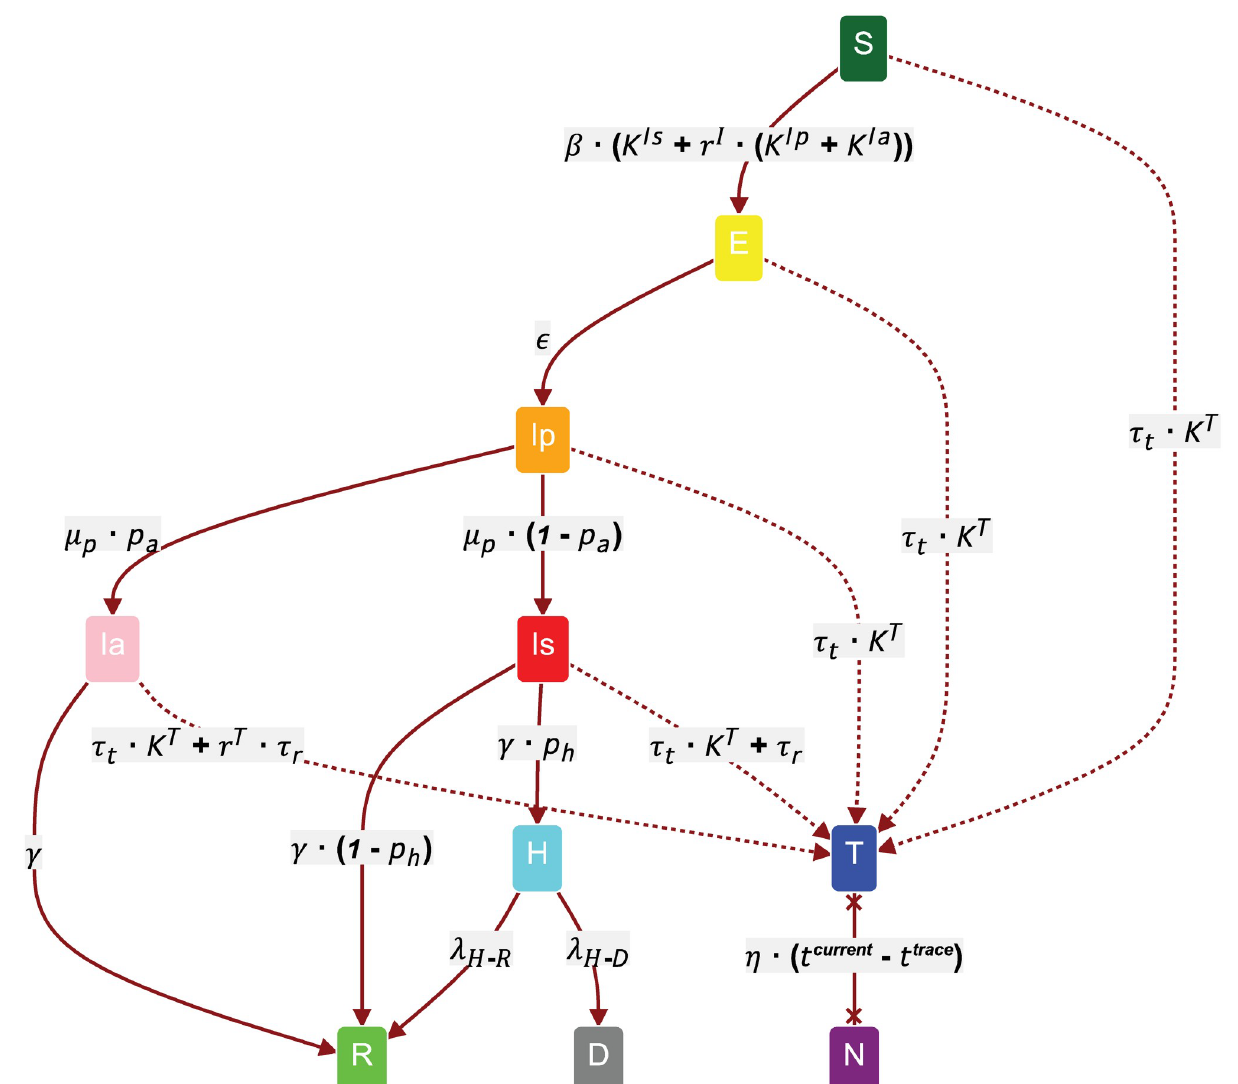
Fig 1. The SEIR-T compartmental model for COVID-19. Each node has 2 allocated variables: an infection state and a tracing status. The infection states from top to bottom are: S —susceptible; E —exposed but not infectious; I p —infectious, presymptomatic; I a —infectious, asymptomatic; I s — infectious, symptomatic; H —hospitalized; R —recovered / removed; D —dead. At any point in time, a node’s tracing status can either be T (traced and isolated) or N (not traced/isolated or non-compliant). Each state transition has a certain time-dependent probability p , and the λ rate of the corresponding exponential to sample from in the continuous-time simulations. represent both p S 1 ! S 2 D t